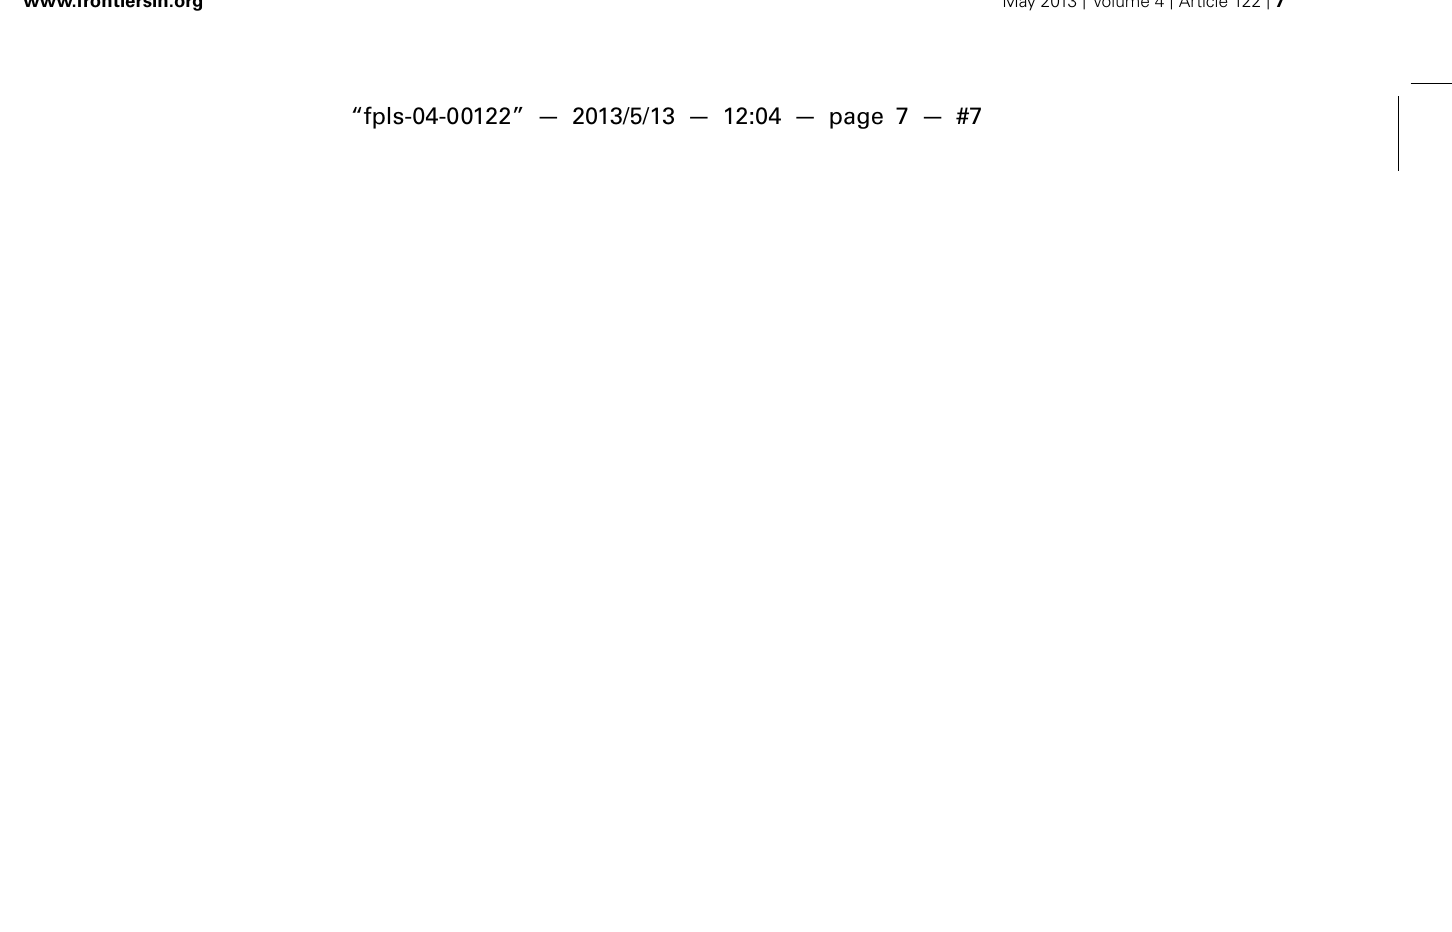
normalized value of CaTin1 (D) , CaPR4 (E) , and CaPR1 (F) were quantified by qRT-PCR at 0 and 6 h after infilteration of X. axonopodis pv. vesicatoria at 10 6 cfu/ml 10 days after bacteria and chemical treatments. Bars represent mean ± SEM with four replications per